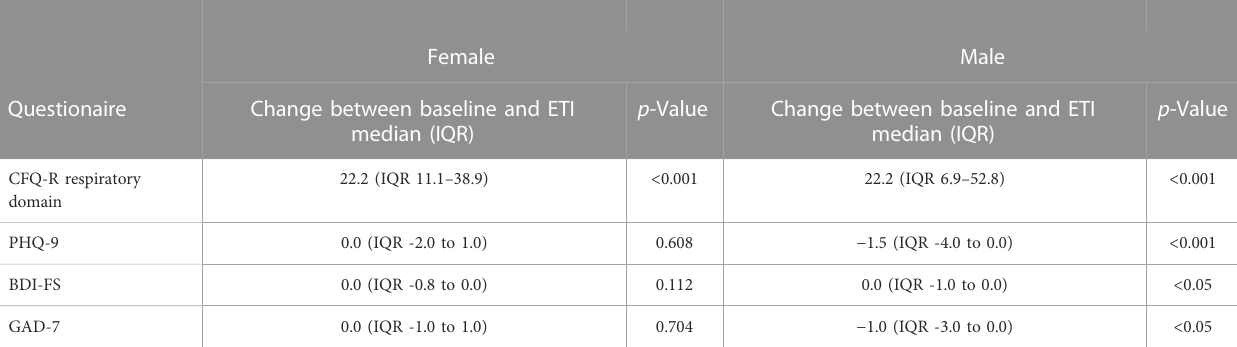
TABLE 3 Sub group analysis of the effects of elexacaftor/tezacaftor/ivacaftor (ETI) in female and male patients with CF on quality of life determined by the Cystic Fibrosis Questionnaire-Revised (CFQ-R), symptoms of depression determined by Patient Health Questionnaire-9 (PHQ-9) and Beck ’ s Depression Inventory- FastScreen (BDI-FS), and symptoms of anxiety with the Generalized Anxiety Disorder Scale-7 Items